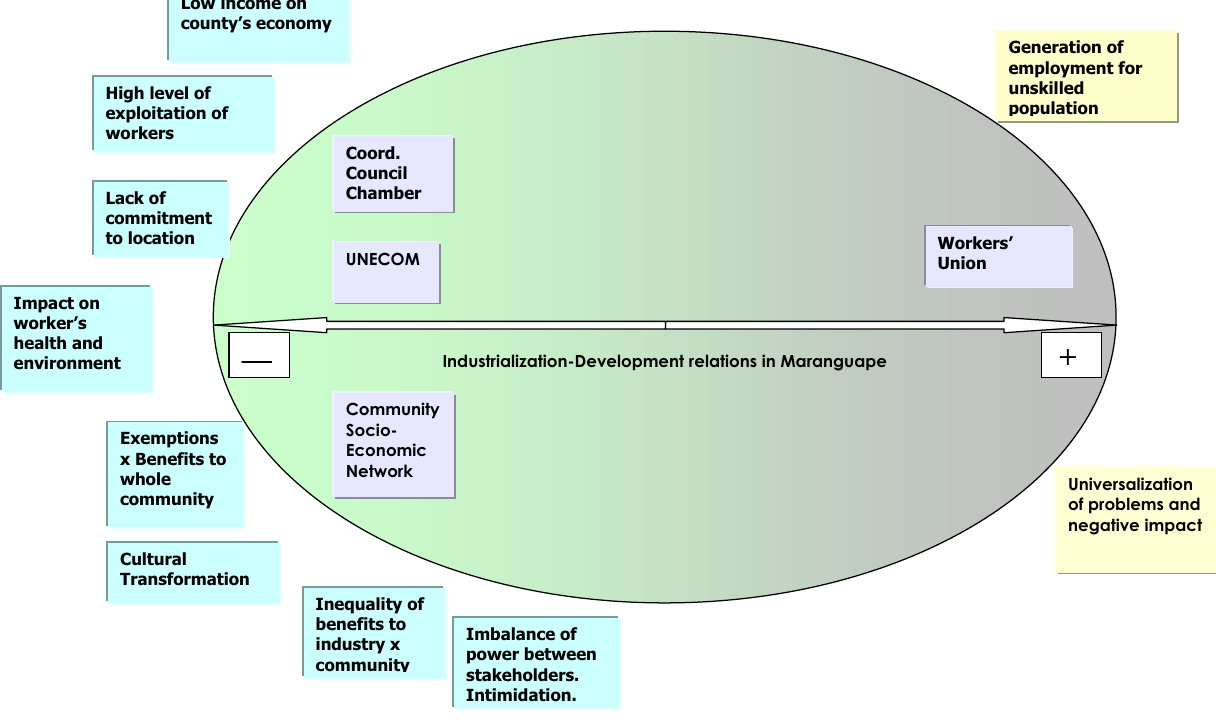
Figure 3. Positions of discourse of social stakeholders in Maranguape community regarding industrialization-development relations and symbols which sustain